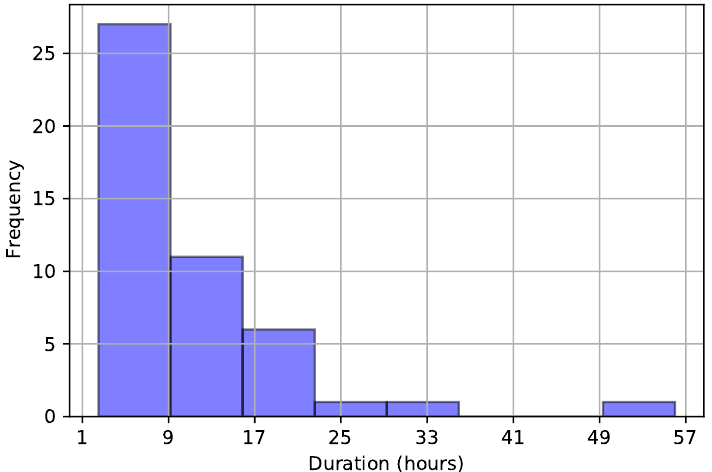
Figure 10. A histogram showing a distribution of course durations in Thailand.